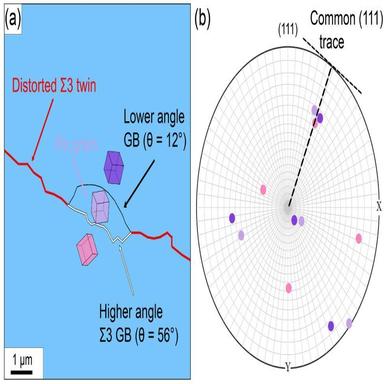
Graphical example of a DRX grain that nucleated at a distorted twin; (a) the boundary map of a DRX grain between two deformed grains along a distorted twin boundary; the cubes represent the crystal orientation of the grains and (b) their orientations are indicated in the respective colours in the (111) pole figure. (reproduced after modification from with permission).